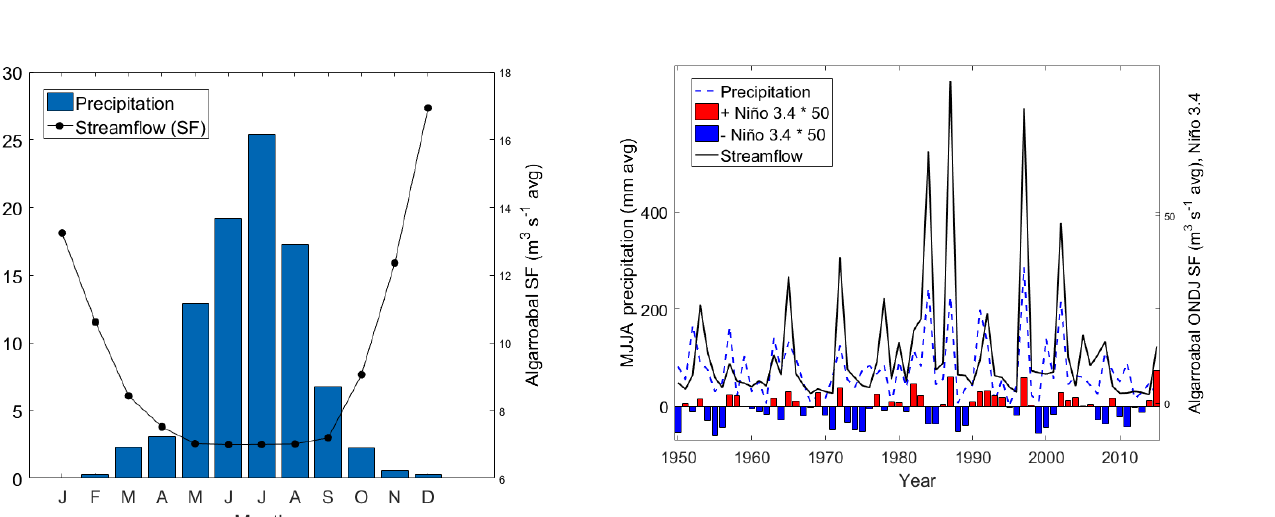
Figure 1. Location of Elqui River valley, Chile.